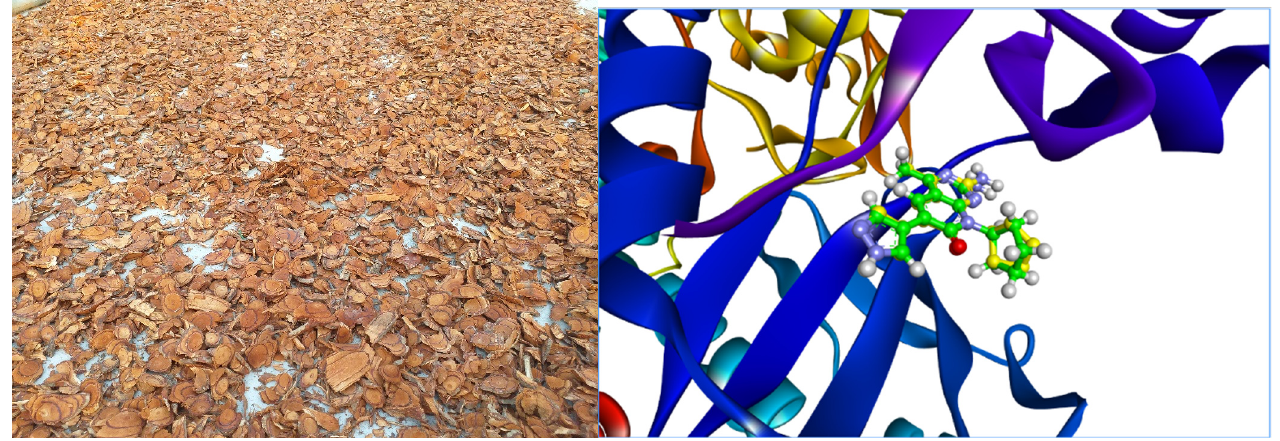
Figure 1. The stems of Millettia dielsiana and docking of the co-crystallized ligand to the PI3K α /mTOR structure 4FA6. The initial ligand is in green and the docked ligand is in yellow. Table 1. The achieved docking results for the complexes of the studied compound and reference compound (PI3Kalpha/mTOR-IN-1) with PI3K α /mTOR the target protein.